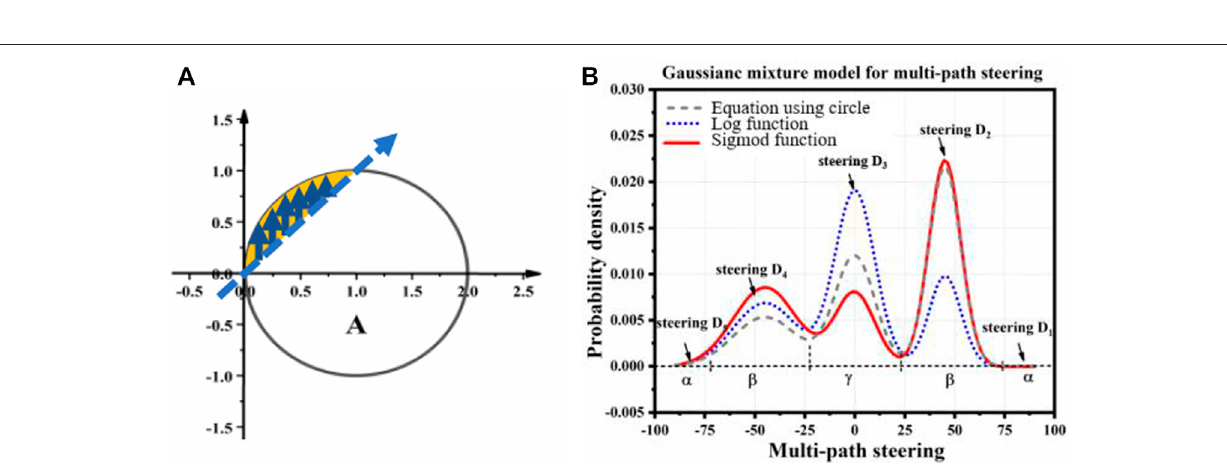
Frontiers in Energy Research |